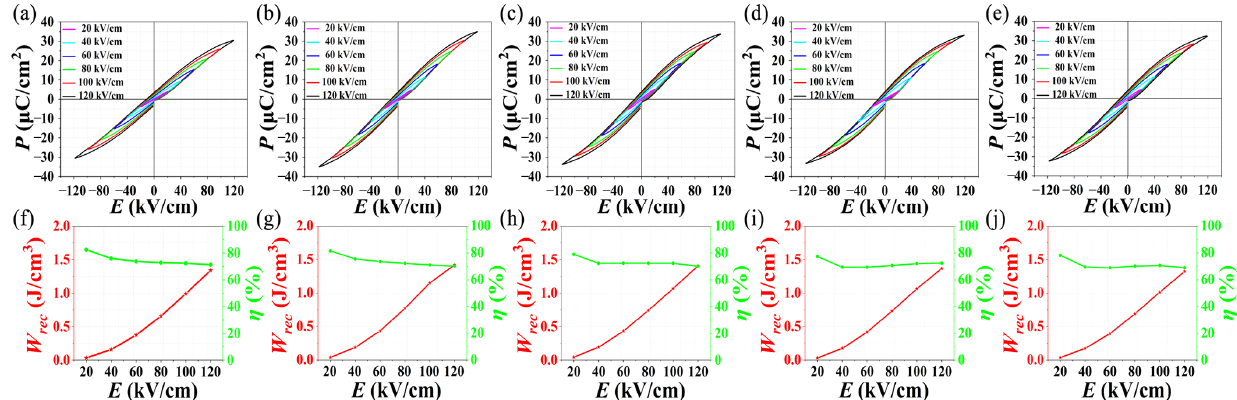
Figure 5. Room temperature P-E loops under different sintering temperatures for the NBT-BT-NN ceramics ( a ) 1000 °C, ( b ) 1050 °C, ( c ) 1100 °C, ( d ) 1150 °C, ( e ) 1200 °C, ( f – j ) shows the variation of W rec and η as a function of the applied field.